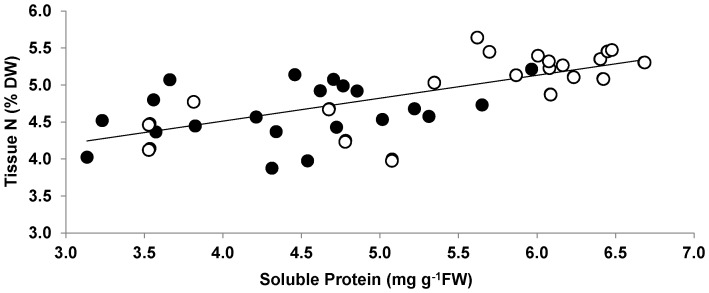
Soluble protein vs. tissue N of Porphyra umbilicalis from the upper intertidal zone.All samples from the experiment period are pooled here. Porphyra was cultivated under ambient sunlight in a greenhouse, with sunrise and sunset at ca. 07∶00 and 18∶00, respectively. Filled circle: control, open circle: emerged. Regression is highly significant (F1,40 = 35.3, p<<0.001).